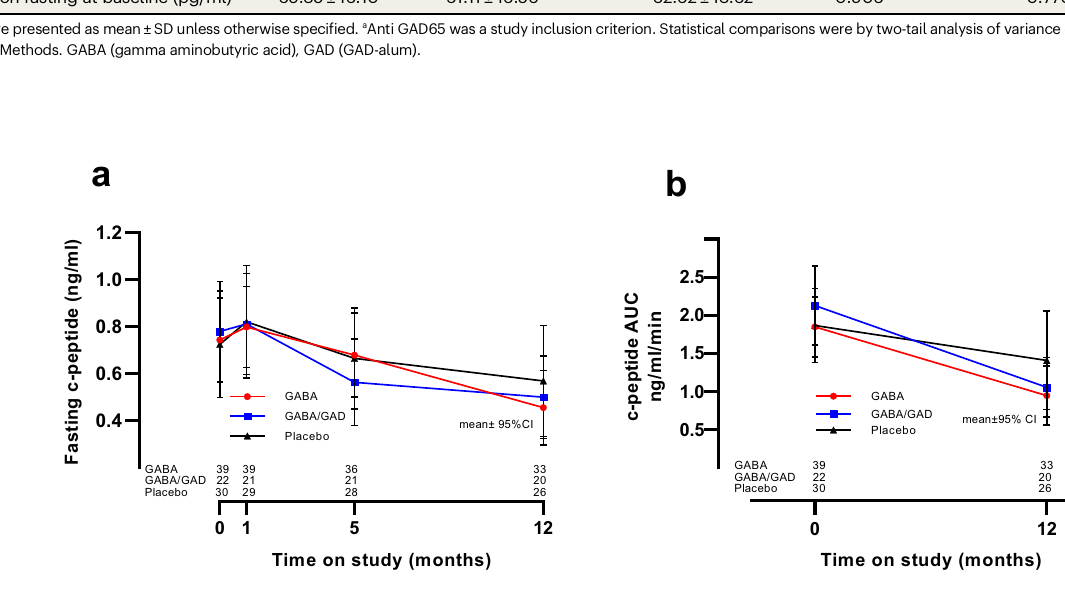
Results are given as mean±95% CI. No statistical differences were noted by two- sided analysis of covariance (complete statistical data is summarized in Supple- mentary Table 1). Source data are provided as a Source Data fi le.